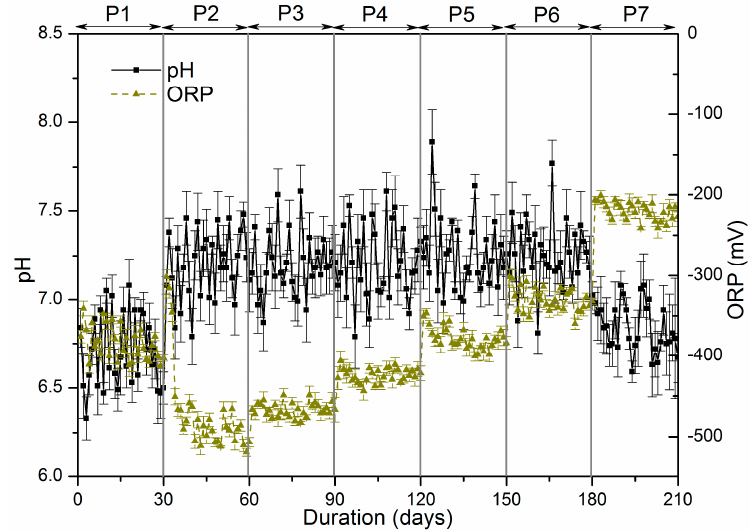
Figure 2. Variation of pH ( ■ ) and oxidation-reduction potential (ORP, ▲ ) under anaerobic and microaerobic conditions during semi-continuous digestion of activated sludge supplemented with RSI (error bars represent standard deviation, n = 3).